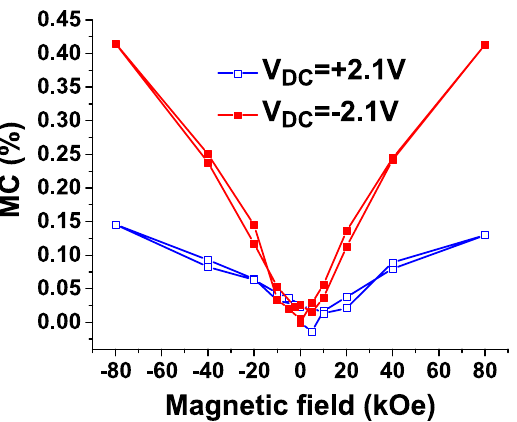
Figure 3. MC values for the data shown in Fig. 2 as a function of the magnetic field at large applied bias with no ferroelectric